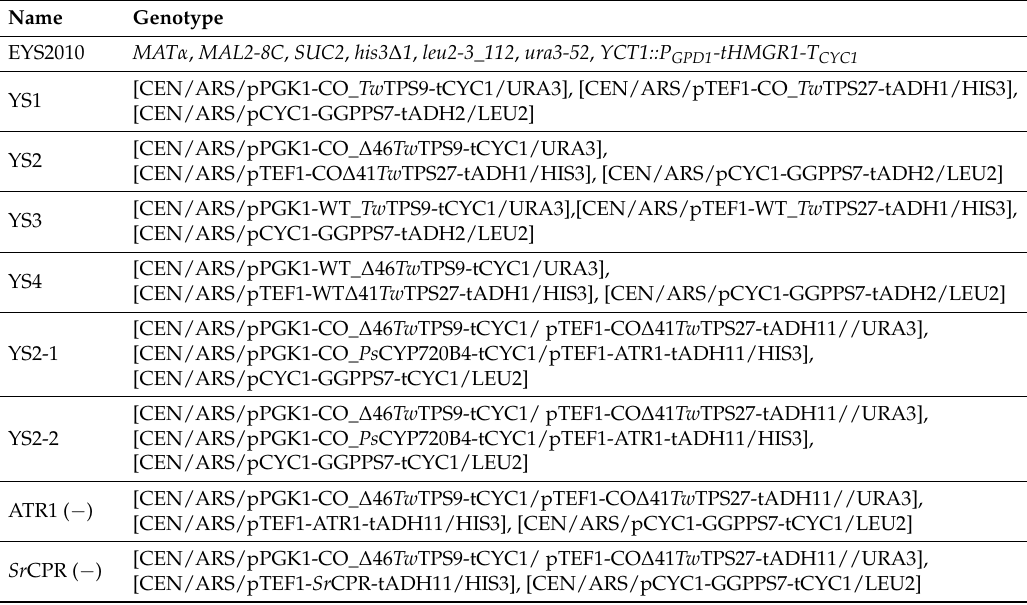
Table 1. Yeast strains used and generated in this